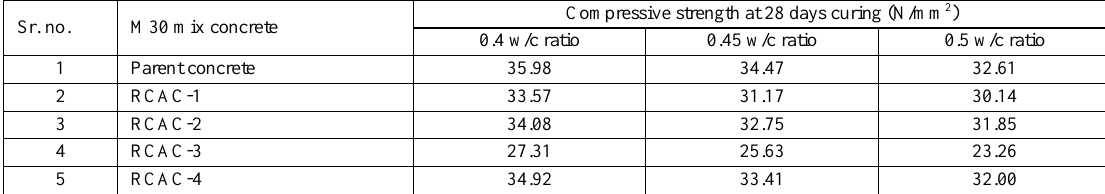
Table 6. Test results of M30 mixes